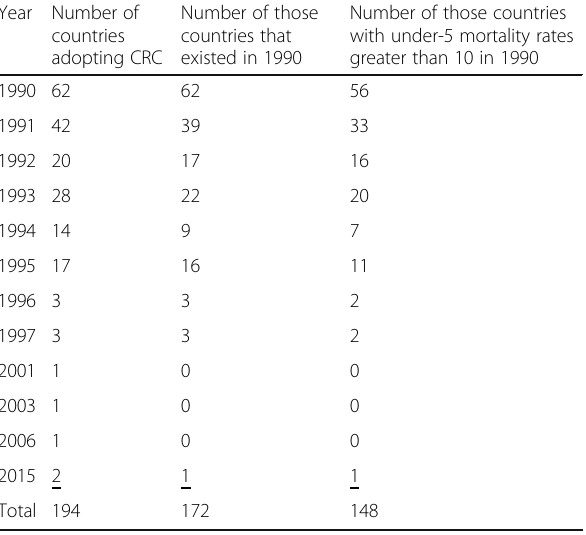
Table 1 Adoption timing of the Convention on the Rights of the Child Year Number of countries adopting